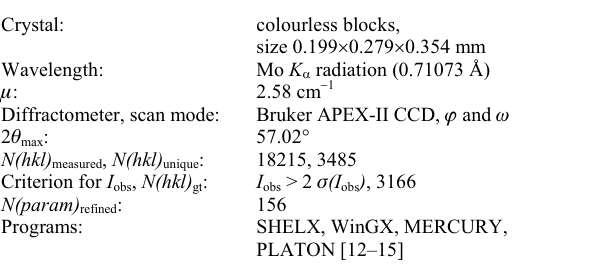
Table 1. Data collection and